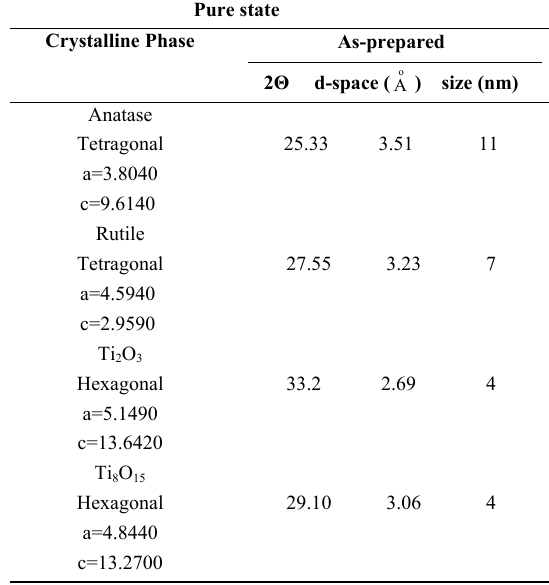
Fig. 2 . XRD patterns of pure TiO nanorod and Al 2 doped with 6 h and 12 h reflux time. Table 2. The 2 θ angle, d-space, Miller indexes, grain size of pure TiO 2